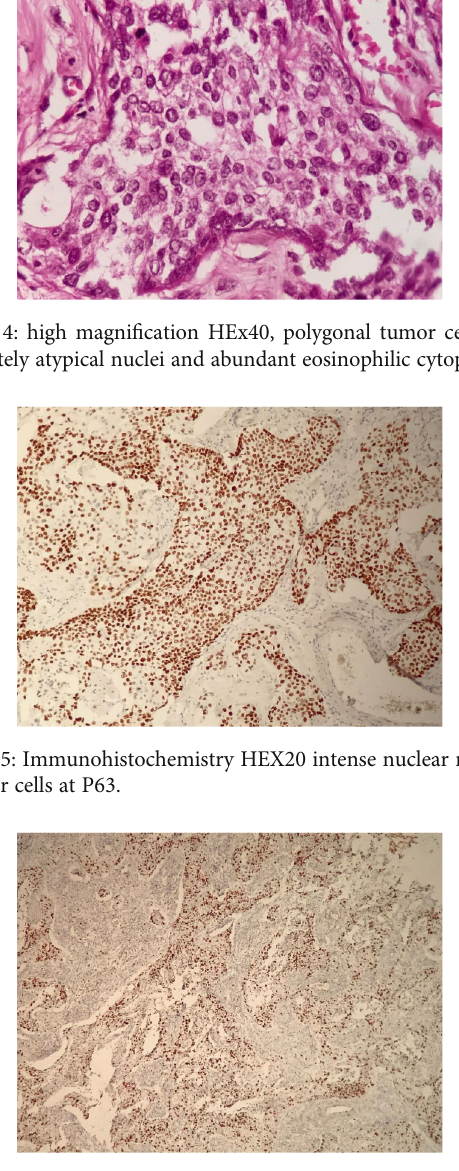
Figure 6: HEx20 Ki67 estimated to more than